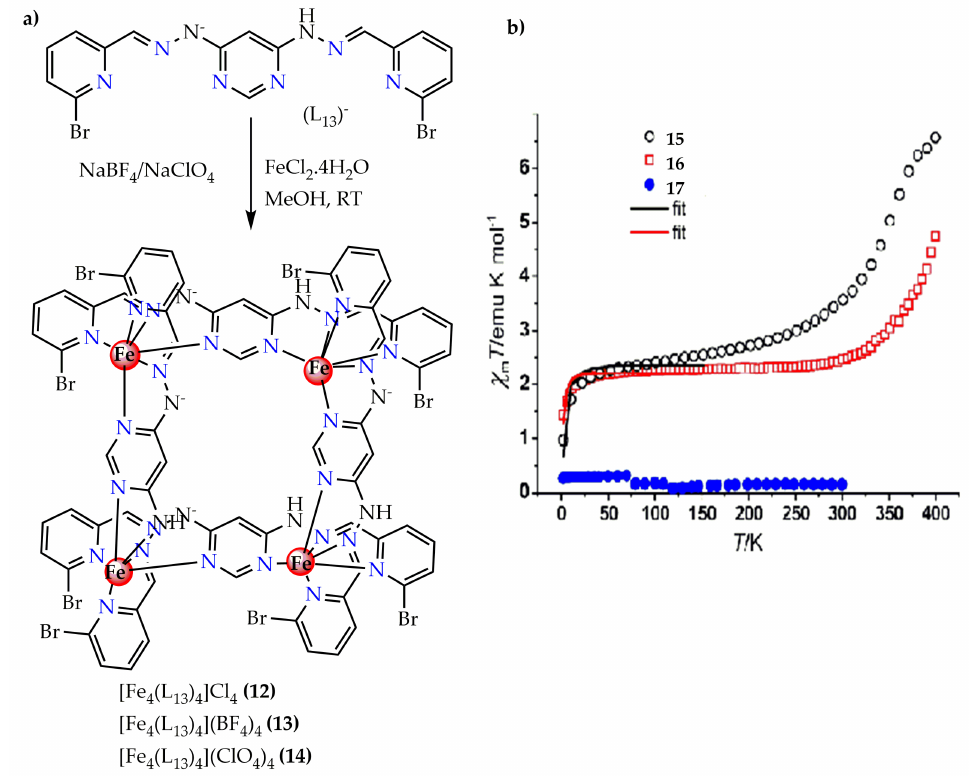
Figure 11. ( a ) Self-assembly synthesis root of complex 15 , 16 and 17 ( b ) χ M T vs. T plot for 12 9H 2 O (black circles), 13 6H 2 O (red squares) and 14 4H 2 O (blue) grid complexes. Reproduced with permission from [94], published by American Chemical Society,